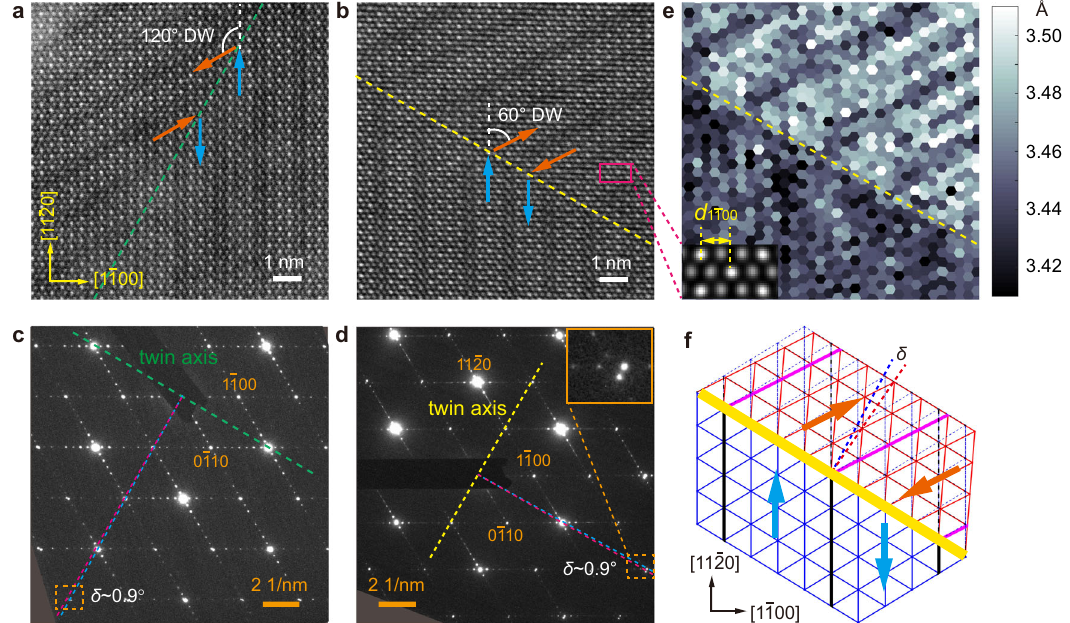
Fig. 2 Multidomain and DW structure in β ’ -In 2 Se 3 . a , b Atomic-resolution ADF-STEM images of 120° and 60° DWs in 2H β ’ -In 2 Se 3 , revealing the unchanged basic structure but the switch of the nanostripe directions across the coherent DWs. c , d SAED patterns of the 120° and 60° DWs. Diffraction spots not on the twin axes show ‘ split spots ’ as magni fi ed in the top-right inset of d . e Horizontal lattice spacing (as de fi ned in the bottom-left inset) mapped around the 60° DW shown in b , re fl ecting lattice dilation along the nanostripes. f Schematic of the 60° DW structure based on SAED pattern in d , which can explain the atomic structure and lattice distortion imaged in b and e . The original lattice without twinning is drawn in dashed thin blue lines, which reveal a deviation angle δ that matches the separation angle of diffraction spots in d . The antiparallel polarizations of neighboring nanostripes are indicated by blue/orange arrows in a , b and f